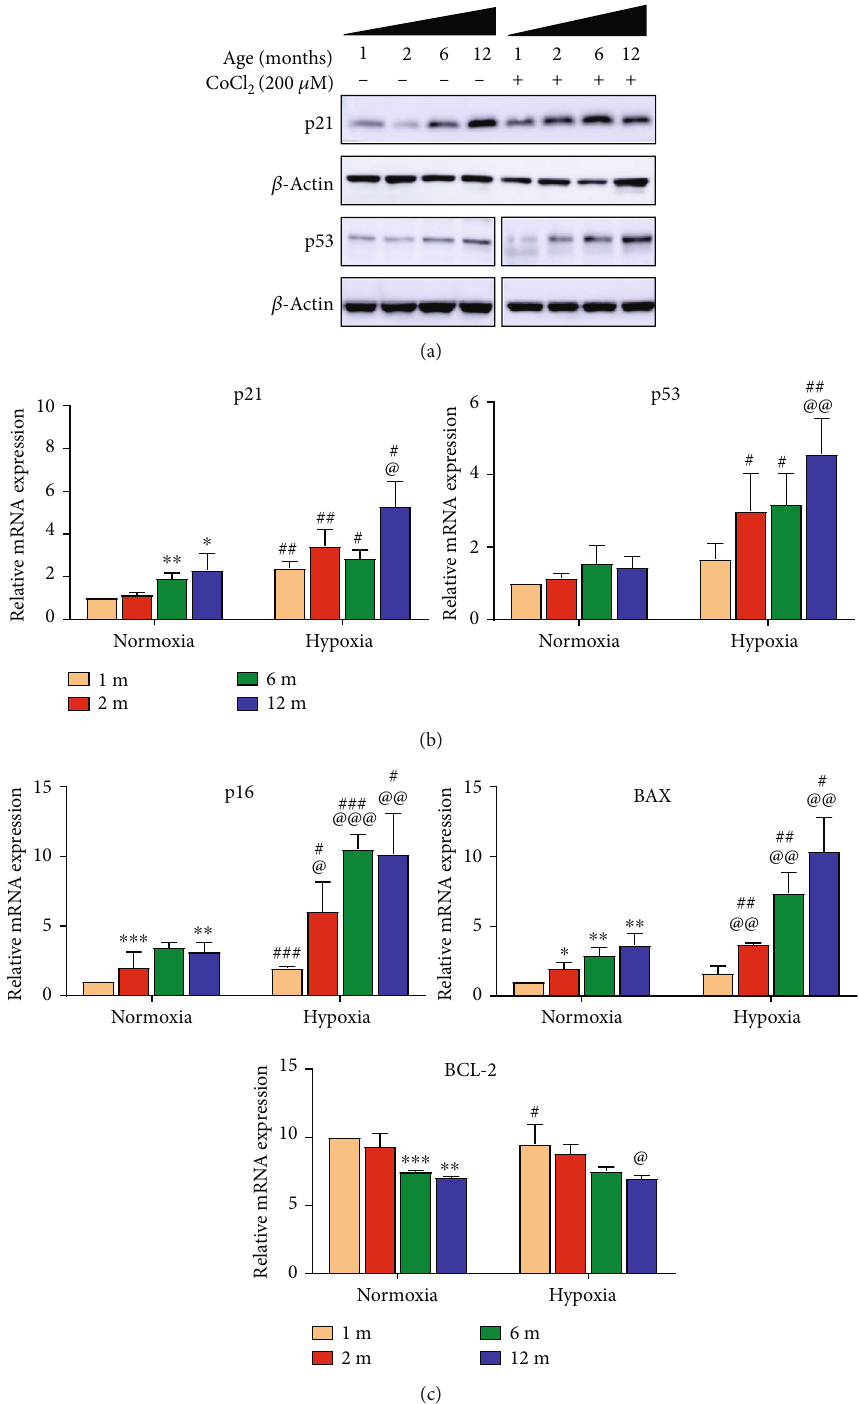
Figure 4: p53/p21 involved in hypoxia response in GG MuSCs. (a) The protein levels of p53 and p21 signi fi cantly increased under hypoxia, particularly in MuSCs derived from older age GG. (b) The mRNA levels of p53 and p21 also obviously grew up under hypoxia. The levels were higher in old GG MuSCs than in young. (c) The mRNA levels of p16 and BAX increased, while BCL-2 increased under hypoxia, especially in aging GG MuSCs. Statistical signi fi cance is marked as follows: ∗ represents the di ff erence between normoxia and 1-month-old vs. 2-month- old vs. 6-month-old vs. 12-month-old; ∗ p < 0 : 05 , ∗∗ p < 0 : 01 , and ∗∗∗ p < 0 : 001 . @ represents the di ff erence between hypoxia and 1-month-old vs. 2-month-old vs. 6-month-old vs. 12-month-old; @ p < 0 : 05 , @@ p < 0 : 01 , and @@@ p < 0 : 001 . # represents di ff erence between same age and normoxia vs. hypoxia; # p < 0 : 05 , ## p < 0 : 01 , and ### p < 0 : 001